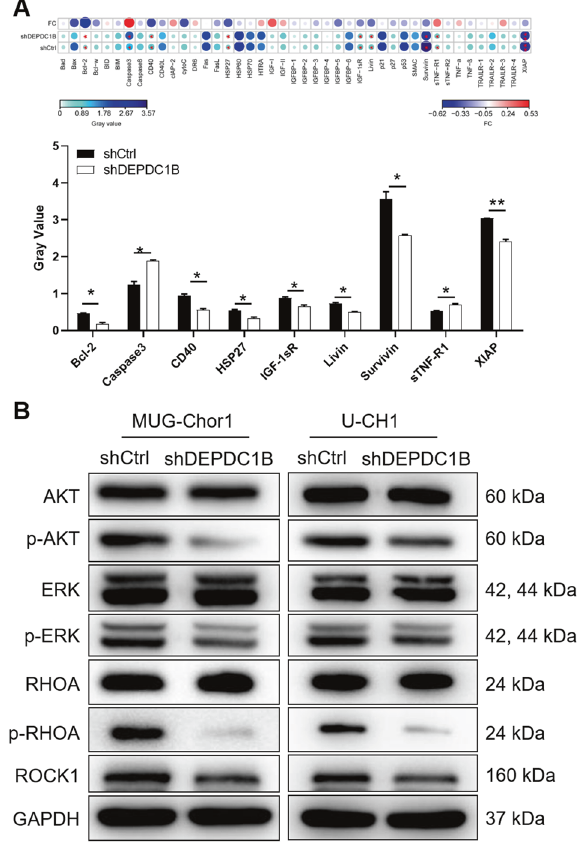
Fig. 2 Knockdown of DEPDC1B regulates apoptosis-related factors and AKT, ERK, RHOA/ROCK cascades. A Human apoptosis antibody array analysis was performed in MUG-Chor1cells with or without DEPDC1B knockdown. B We tested the protein expression of AKT, p-AKT, ERK, p-ERK, RHOA, p-RHOA, ROCK1 after the expression of DEPDC1B decreased. Data was shown as mean ± SD. * P <